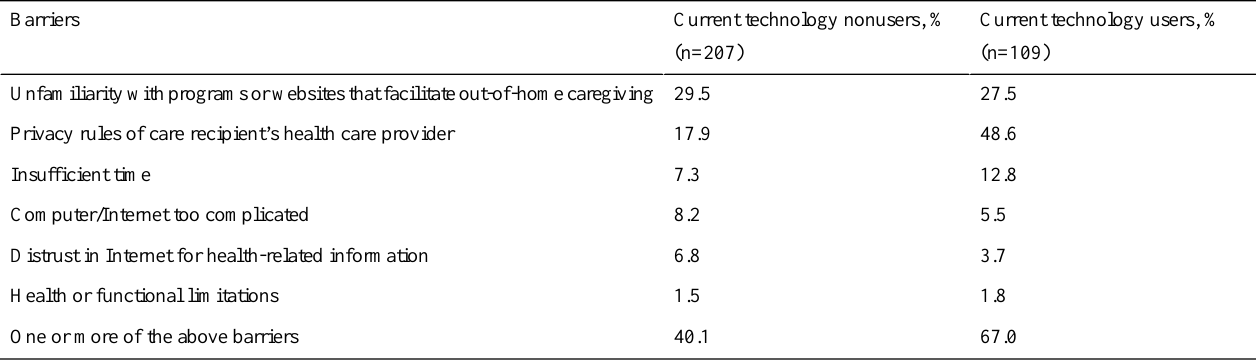
Table 4. Barriers to health information technology use for out-of-home caregiving.